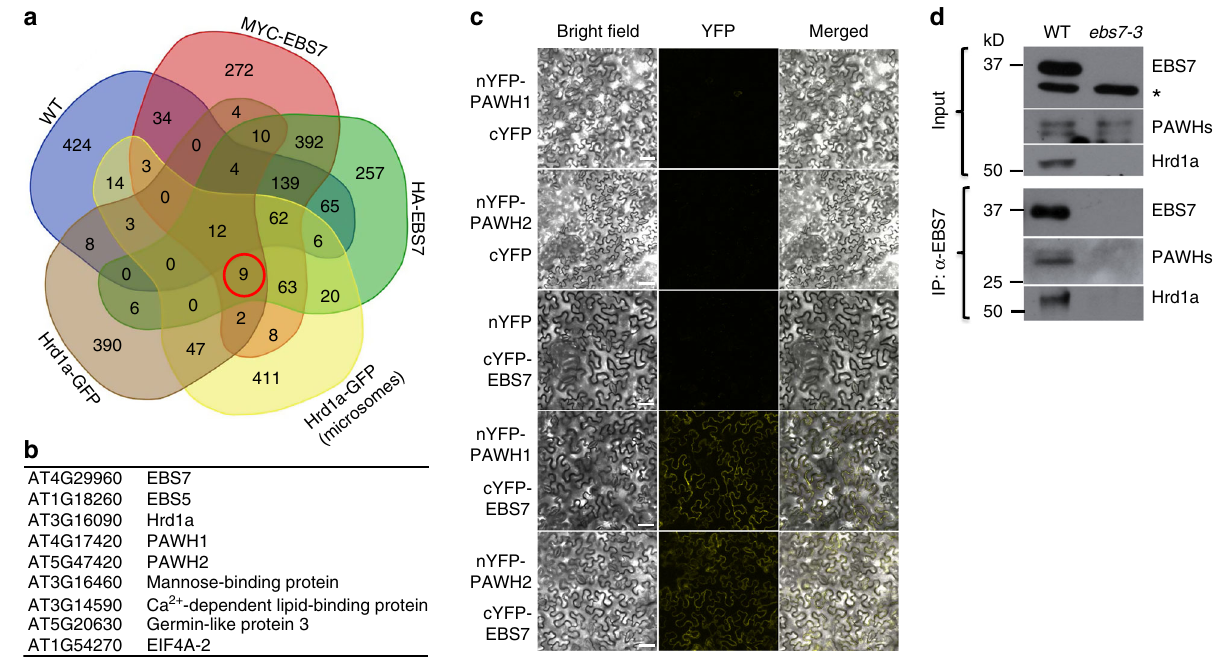
Fig. 1 Discovery and veri fi cation of the two EBS7/Hrd1a-interacting PAWHs. a A Venn diagram of the immunoprecipitated proteins from total/microsomal proteins of the wild-type control or transgenic mutants expressing Hrd1a-GFP or MYC/HA-tagged EBS7. b The list of the nine proteins that were identi fi ed in all four IP-MS experiments. c The BiFC analysis of the PAWH1/2-EBS7 interaction in tobacco leaf epidermal cells. Bar = 50 μ m. d CoIP of EBS7 with PAWH1/2 and Hrd1a in Arabidopsis plants. The total proteins (Input) and anti-EBS7 immunoprecipitates (IP: α -EBS7) were separated by SDS-PAGE and analyzed by immunoblotting with antibodies to EBS7, PAWH, and Hrd1a. The star indicates a non-speci fi c cross-reactive band used to control equal amounts of proteins used for the coIP assays. The positions of molecular mass standards are indicated on the left. The raw data of the IP-MS experiments can be accessed at https://www.ebi.ac.uk/pride/archive with the dataset identi fi er PXD013400, and other source data are provided as a Source Data fi